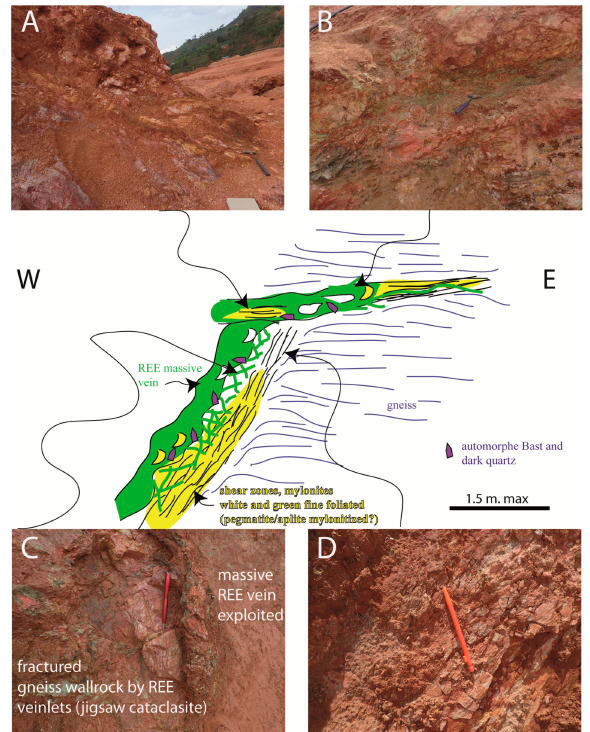
Figure 4. Synthetic line drawing, structures and textures associated with the Gasagwe REE-bearing veins. See text for explanation. ( A , B ) foliated chloritized mylonites re-opened during the REE mineralizing event. ( C ) hydraulic breccia (jigsaw cataclasite) developed during the mineralizing event in the gneissic wall rocks. ( D ) ductile lineations on a shear plane crosscutting the gneiss